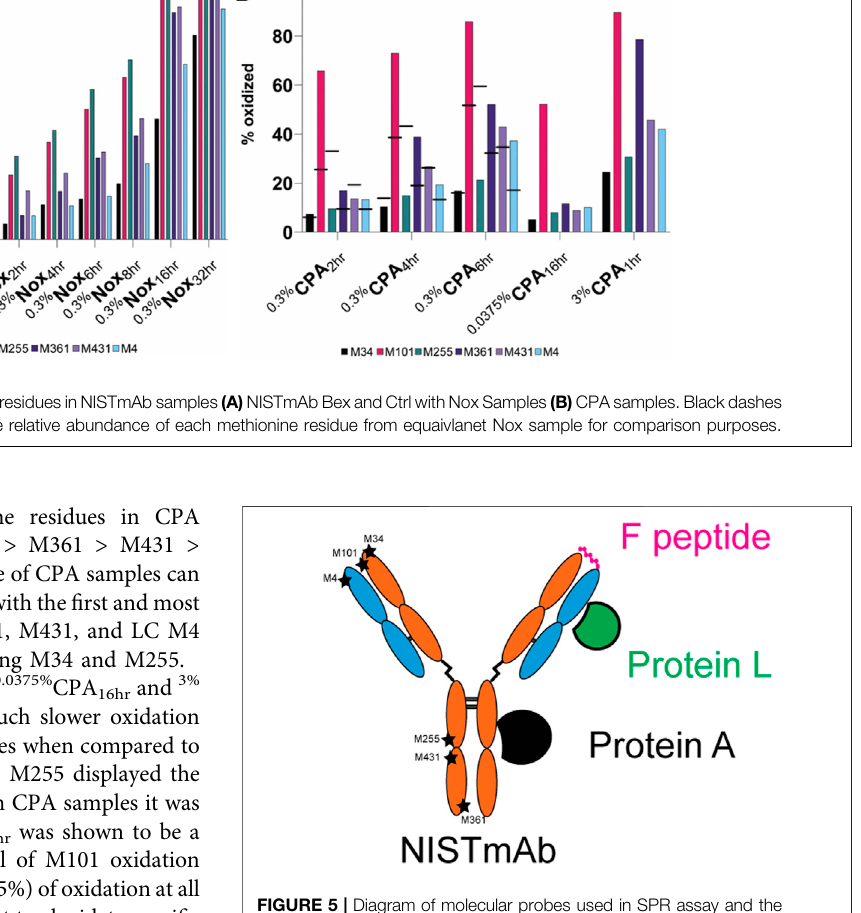
FIGURE 5 | Diagram of molecular probes used in SPR assay and the relative location they